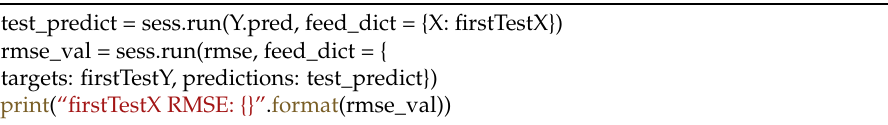
Table 7. Code for displaying test plots for the training model.